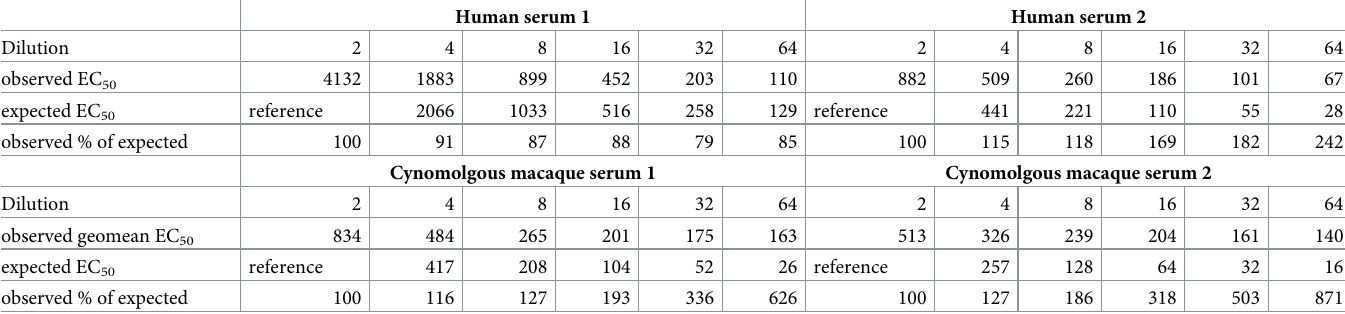
Table 2. Matrix effect observed in human serum and cynomolgus macaque serum.